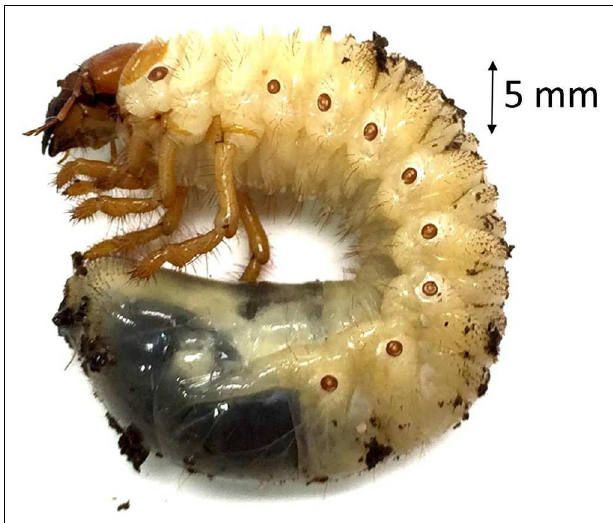
FIGURE 2 | Third instar larva of the greyback cane beetle ( D. albohirtum ). Image supplied by Adam